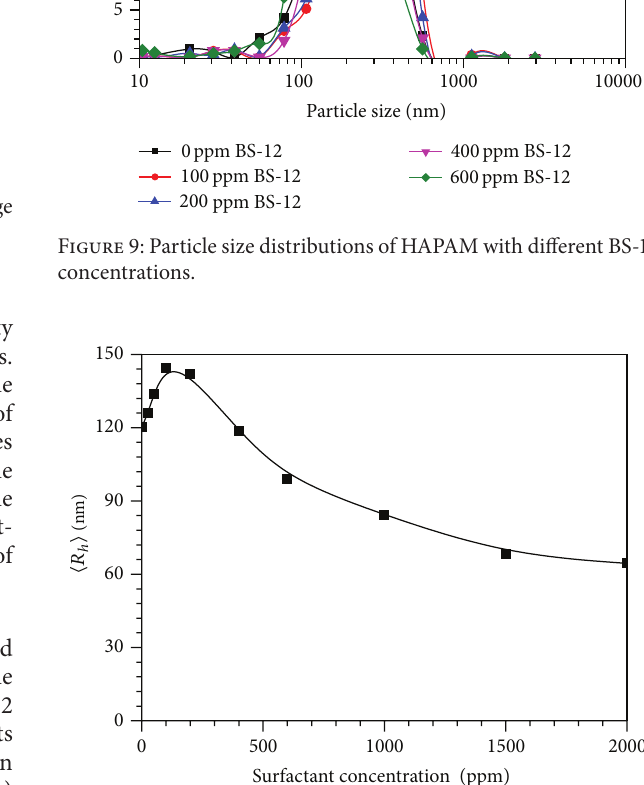
Figure 10: Effect of BS-12 concentrations on the hydrodynamic radius (⟨𝑅 ℎ ⟩) of